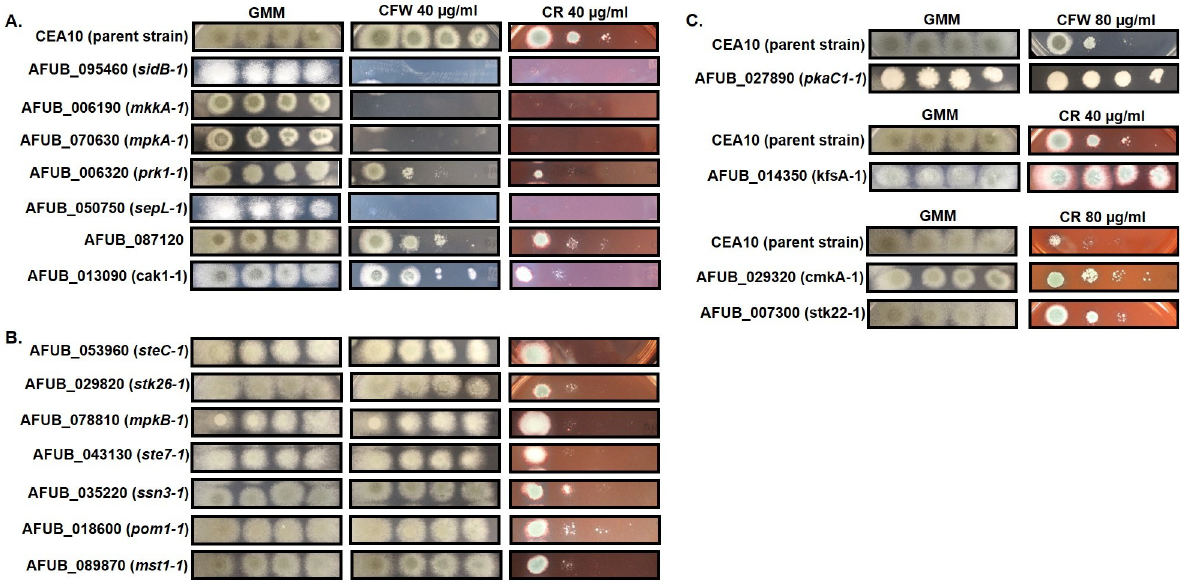
Fig 3. Multiple protein kinases contribute to cell wall integrity in A . fumigatus . A ) Protein kinase gene disruption mutants displaying increased susceptibility to both cell wall disrupting agents, calcofluor white (CFW) and congo red (CR), by spot-dilution assay when compared to the wild type parent (CEA10). B) Protein kinase gene disruption mutants displaying hyper-susceptibility to only CR when compared to the parent strain. C) Protein kinase gene disruptants displaying increased resistance to CFW ( pkaC1-1 ) or to varying concentrations of CR ( kfsA-1 , cmkA-1 , and stk22-1 ). For each target protein kinase gene, the systematic name is listed with the strain name given in parentheses. Strain names were designed using either the previously published or putative (based on homology to Aspergillus nidulans ) gene names with the addition of “-1” to indicate a disruption mutation of that gene. GMM = glucose minimal media with no CFW or CR added. For all assays, conidial inocula were applied at 10 4 , 10 3 , 10 2 , and 10 1 total conidia and plates were incubated at 37˚C for 72 hrs.